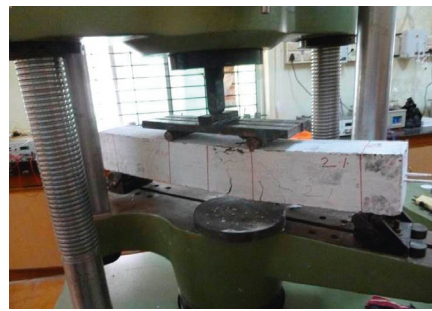
Figure 4: Flexural test experimental